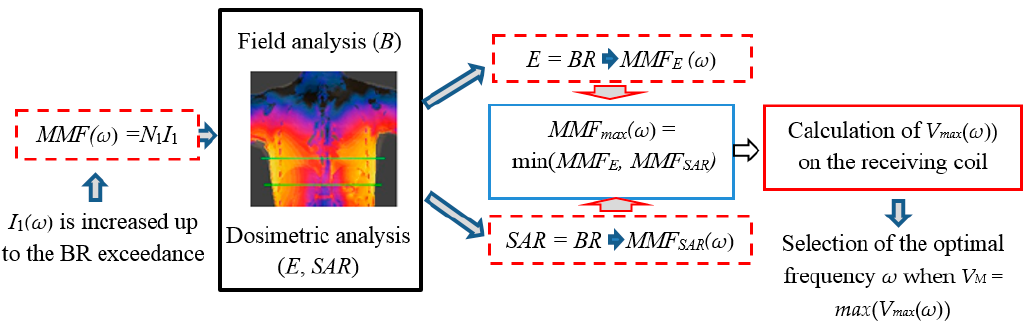
Figure 4. Maximum admissible magnetomotive force MMF vs. frequency.